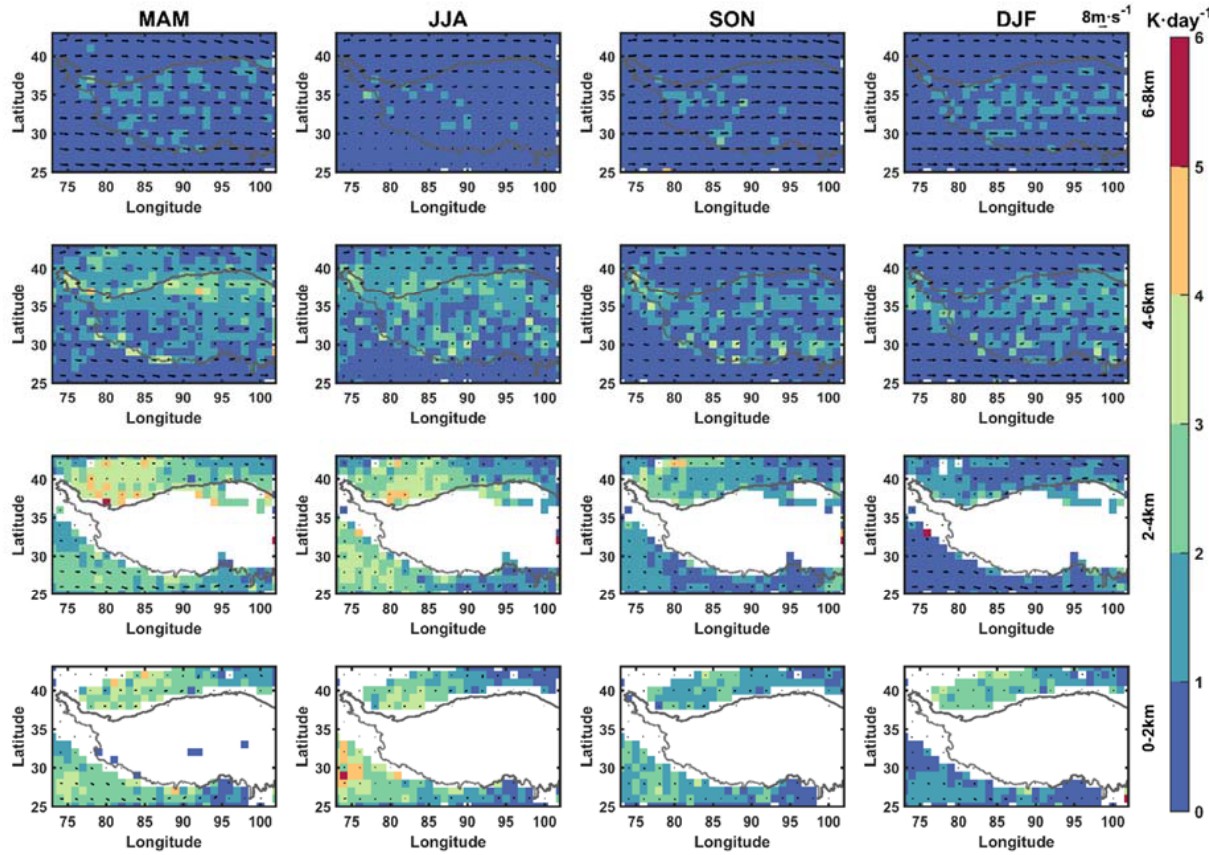
Figure 13. Distributions of linear annual trends of the seasonal SW DHRs during 2007 − 2020 on four longitudinal transects. The black point represents the linear trend passing the significance test at the level of 0.05.